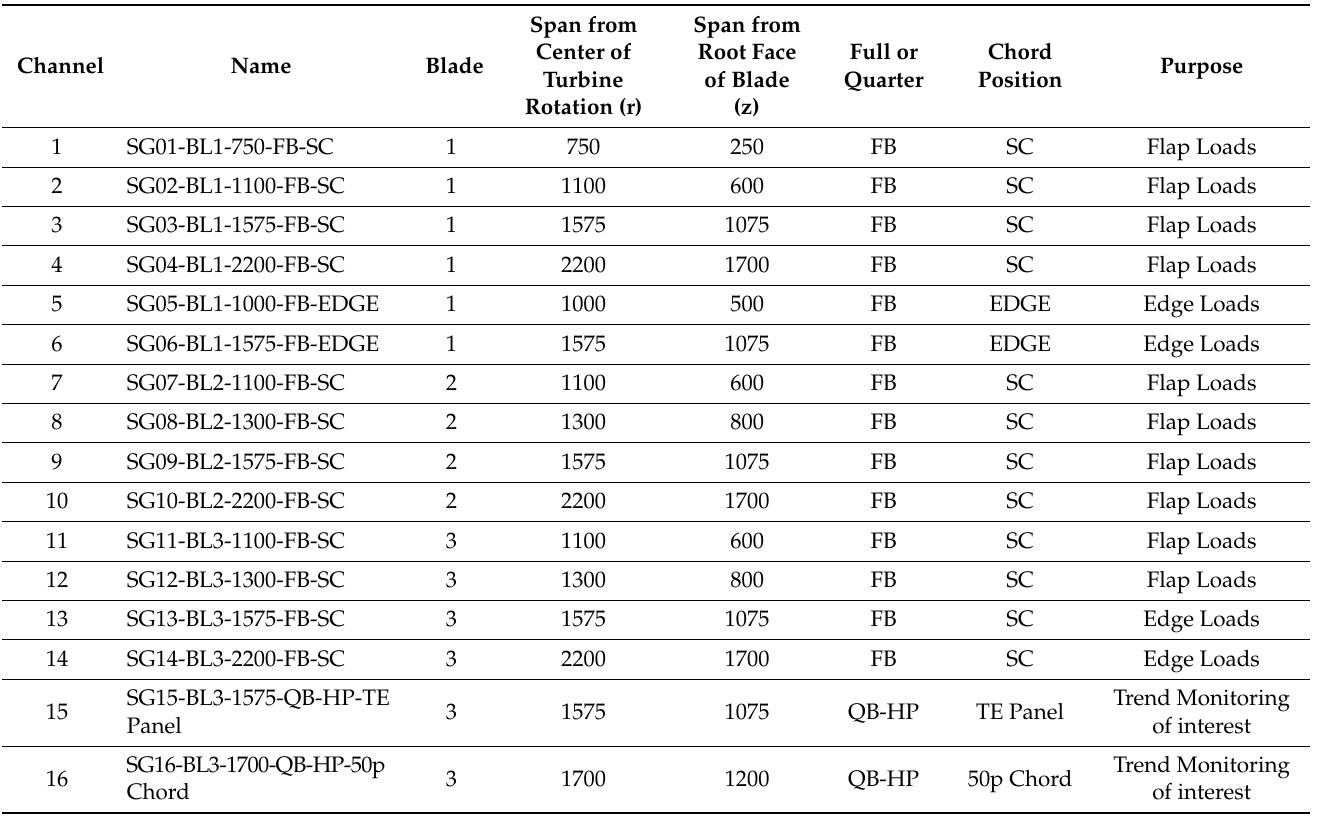
Table 1. Strain gage channel list for thermoplastic Blades 1, 2, and 3. For the labeling of the strain gages in column two, SG denotes “strain gage,” BL denotes “blade” (Blade 1 is BL1), FB denotes “full bridge,” QB denotes “quarter bridge,” SC denotes “spar cap,” and HP denotes “high pressure skin,” giving the location of the strain gage on the